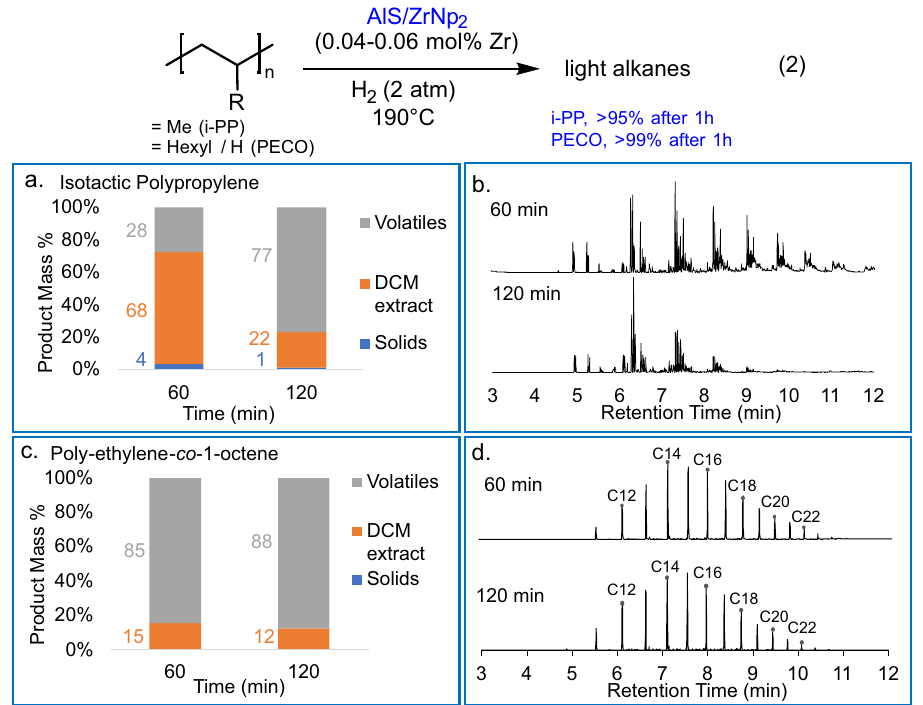
Fig. 3 | Catalytic hydrogenolysis of branched polyole fi ns. a Temporal product distributions for the AlS/ZrNp 2 -catalyzed i-PP hydrogenolysis (190°C, 2.0atm H 2 0.04mol% Zr). b GC/MS chromatograms of DCM extracts from i-PP experiments.